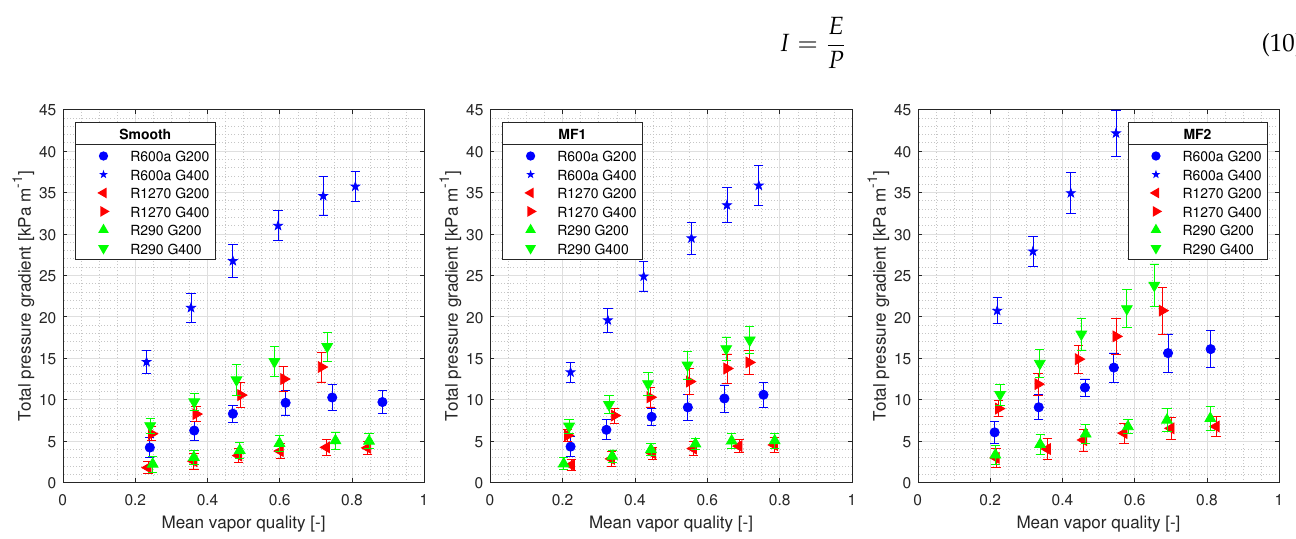
Figure 9. Effect of mass flux on total pressure gradient, mass flux (G) in legend reported in kgm − 2 s − 1 .